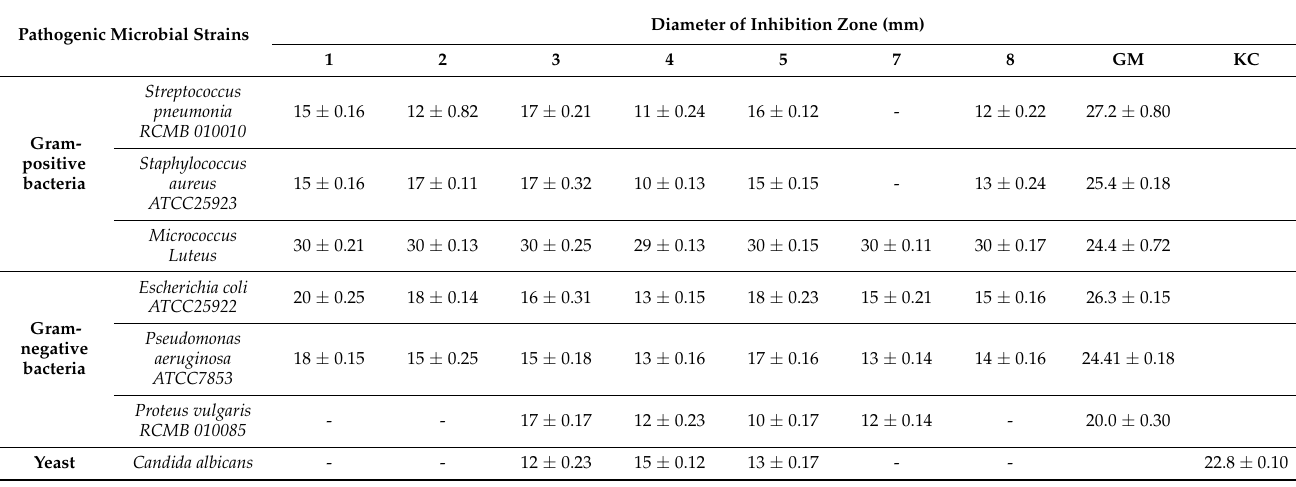
Table 2. Antimicrobial activity of the newly synthesized targets using the well diffusion assay method. Pathogenic Microbial